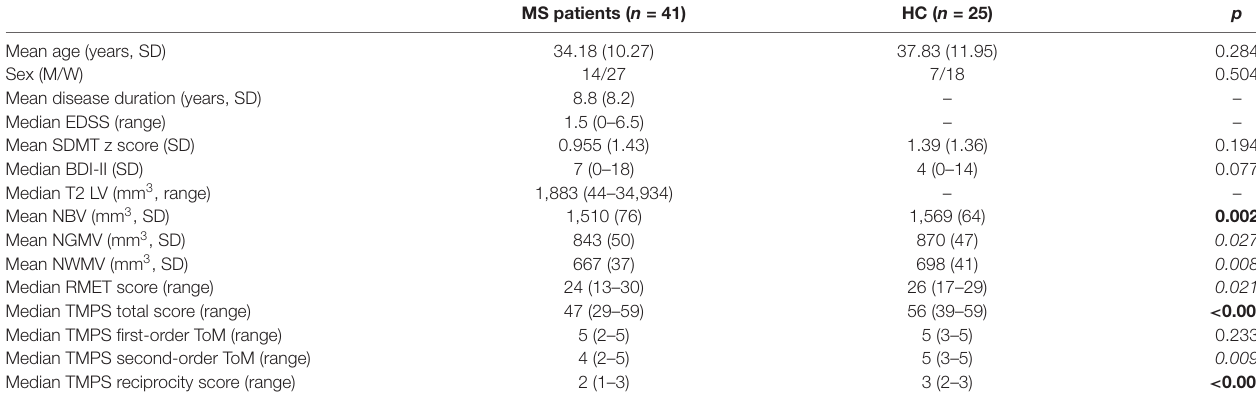
TABLE 1 | Socio-demographic and clinical characteristics of multiple sclerosis (MS) patients and healthy controls (HC) and group comparisons.